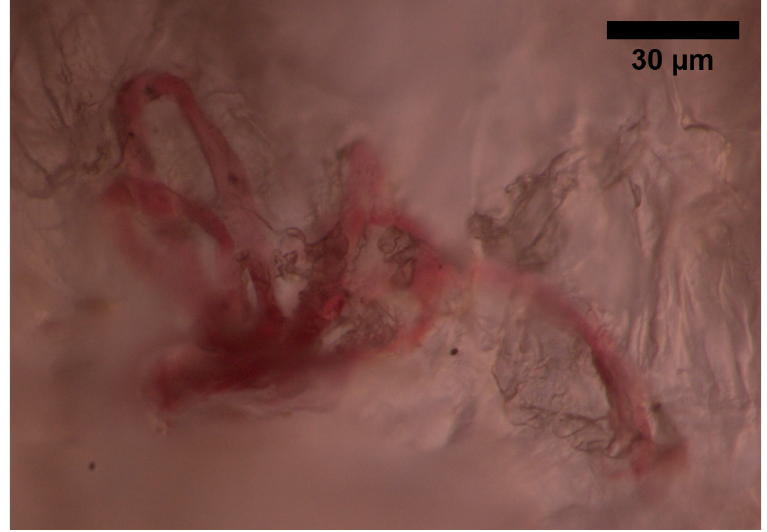
Figure 4. Image of a capillary loop from a sample of pig skin obtained with an optical microscope and an M-Plan APO 50 × 0.55 NA microscope and an M-Plan APO 50 × 0.55 NA microscope objective.